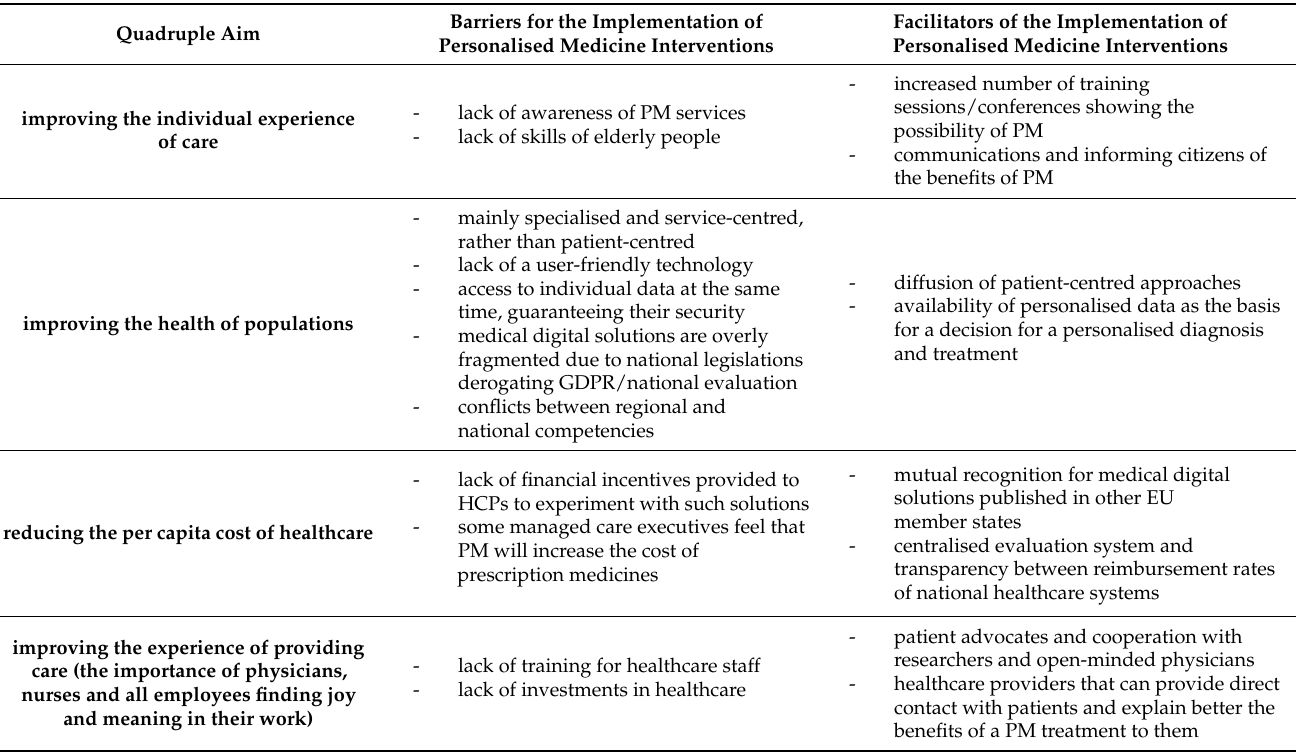
Table 3. Expected barriers and facilitators for the implementation of the Quadruple Aim